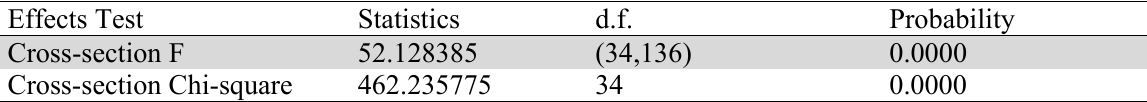
The results of Chow test